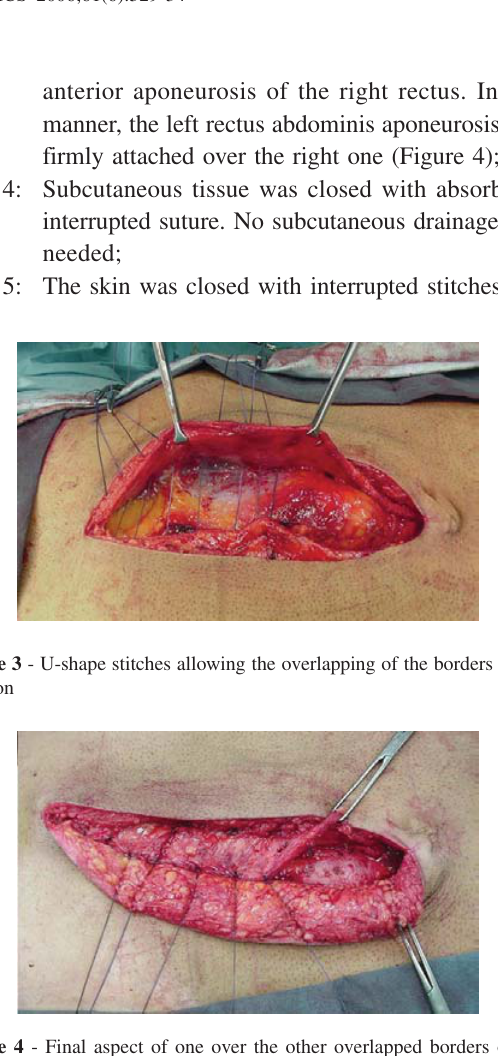
Figure 4 - Final aspect of one over the other overlapped borders of the incision